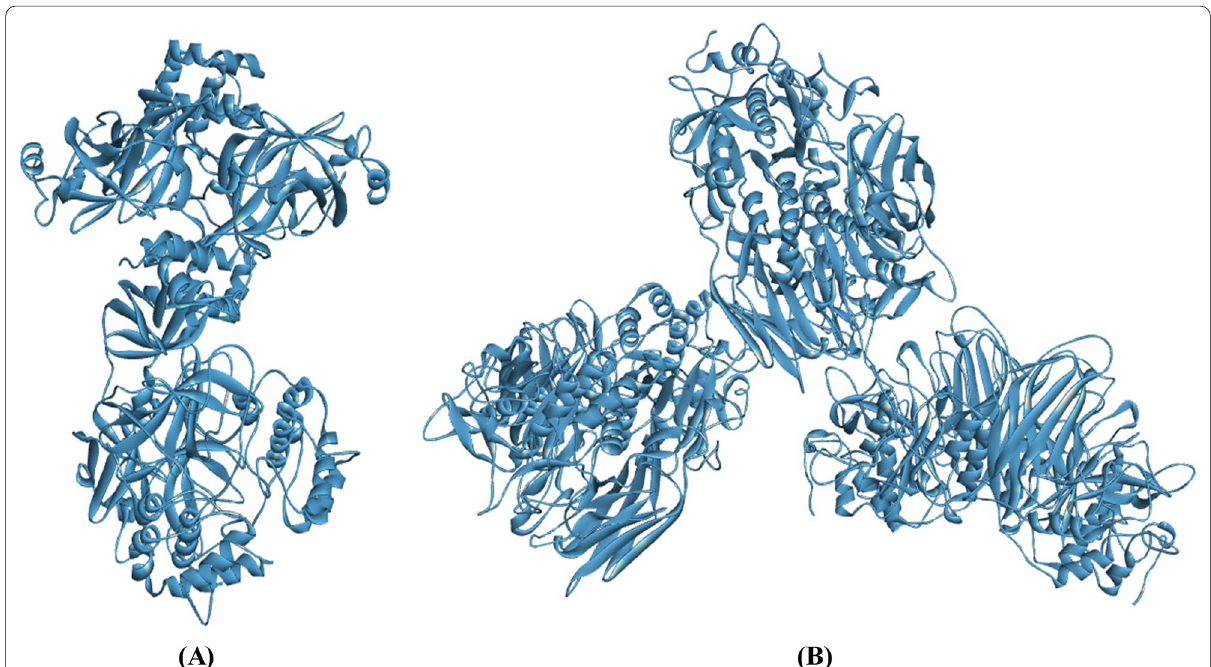
Fig. 1 X-ray crystal structures of ( a ) SARS-CoV-2 M pro and ( b )